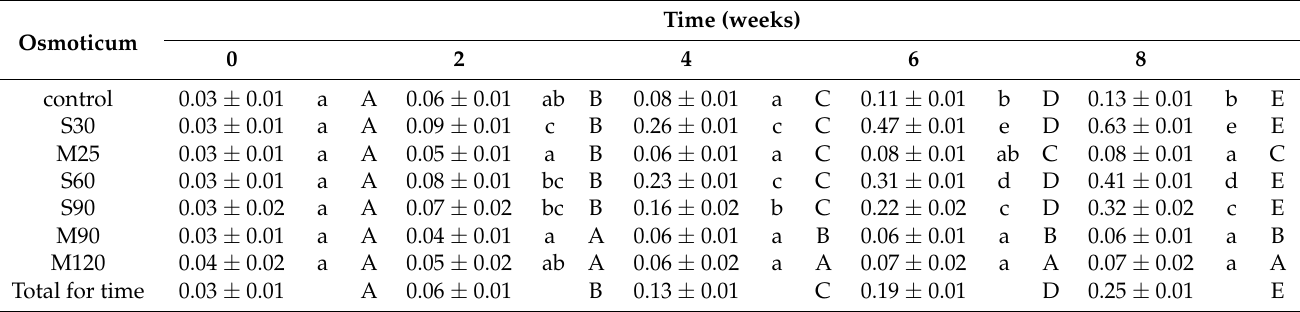
Table 11. Mean ± SE fresh weight (FW) (g) of R. pseudoacacia clones (10PT, 4SO, 6SO) for different treatments measured after 0, 2, 4, 6, and 8 weeks of drought stress exposure. Different treatments are denoted as “control”—medium without osmoticum, “S30”—medium with 30 gL − 1 of